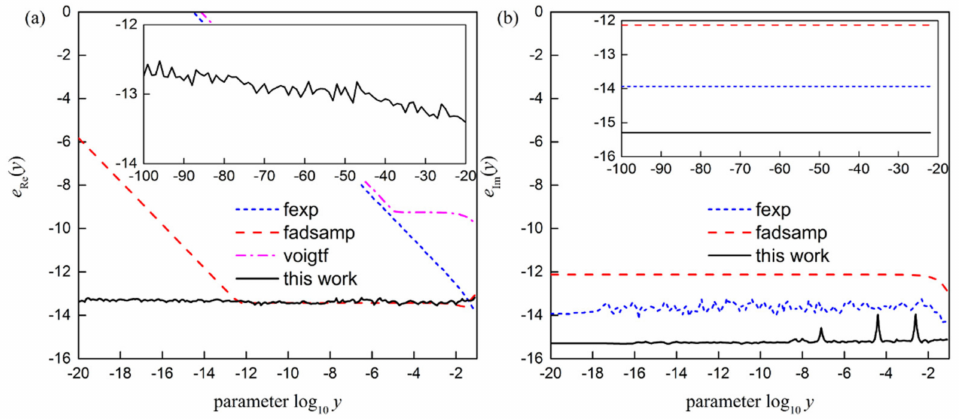
Figure 6. The maximum relative error for the ( a ) real part and ( b ) imaginary part of complex error